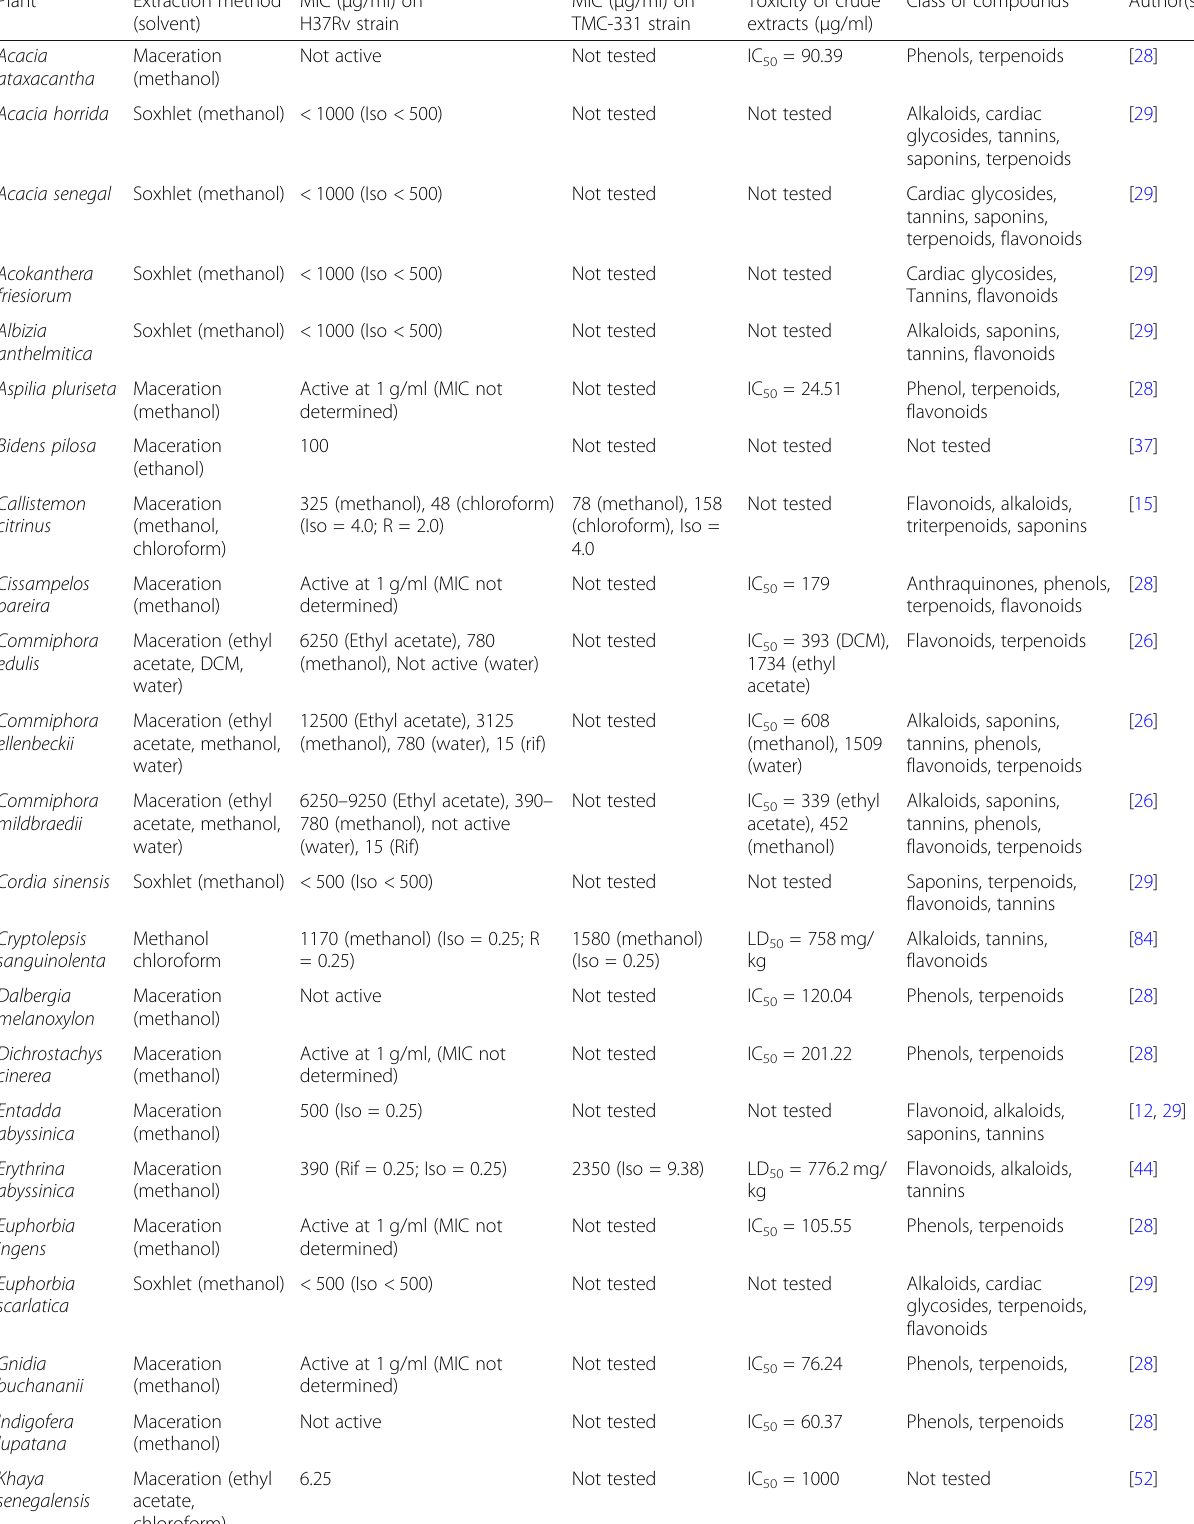
Table 2 Efficacy, toxicity, and phytochemical studies on medicinal plants used for treatment of TB in East Africa